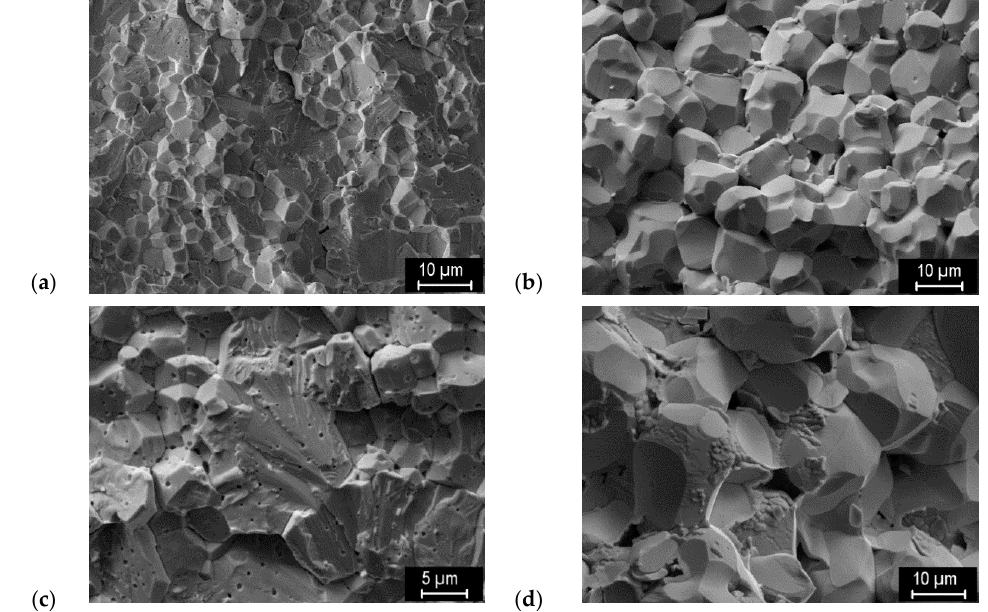
Figure 10. Fracture surfaces of the CLC15 ( a ), CLW15 ( b ), ULC15 ( c ) and ULW15 ( d ) samples. Metals 2019 , 9 , x FOR PEER REVIEW Table 3. Bending strength of the CLC15, CLW15, ULC15 and ULW15 samples.